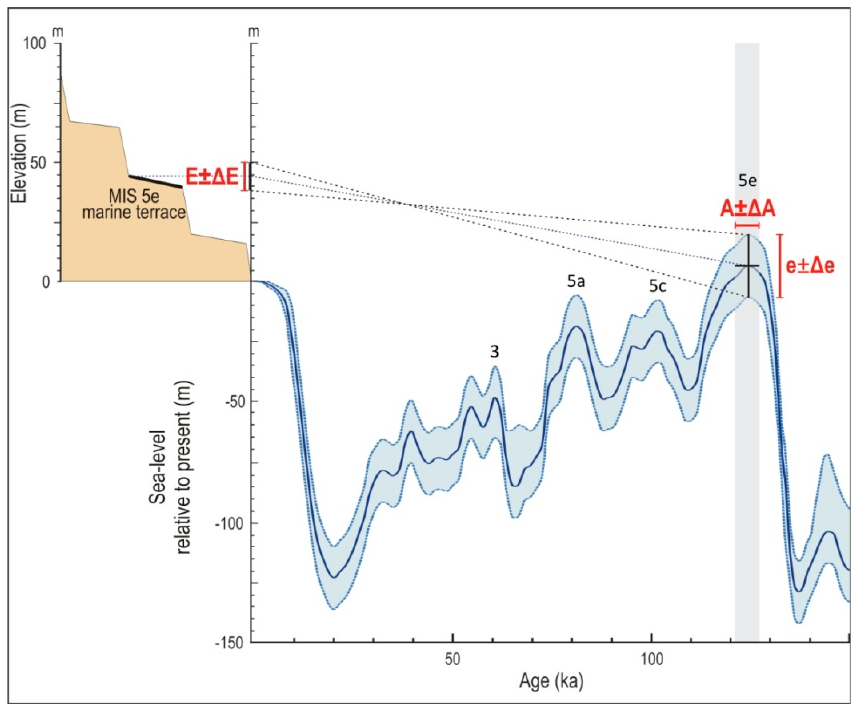
Figure 3. Schematic representation of the uncertainties taken into account for the long-term uplift rates estimations, as well as for the correlation of the marine terraces with past sea-level highstands. E is the present-day elevation of the inner edge of the terrace, A is the age of the terrace, e corresponds to the elevation of the sea level at the time of terrace formation, and the delta symbols ( Δ ) represent the estimated uncertainty in the different parameters. The marine terrace of MIS 5e is used as an example. The age of the other undated terraces has been inferred from their correlation with past MIS sea-level highstands. Assuming a temporally constant uplift rate [4–6,8,20,89] and taking into account the duration of each MIS [88] as well as the maximum and minimum position of eustatic sea-level for each MIS highstand [25], we estimated the “expected” (or “predicted”) elevation ranges of the inner edge for each MIS marine terrace. The predicted elevations were then compared with the observed elevations of the marine terraces, and for each terrace, an MIS was assigned. This is a model generally used since the dating of marine terraces is sometimes difficult, and very often, only one—if any— terrace can be reliably dated. 4. Results and Discussion 4.1. Mapping The application of mapping techniques led to the identification of a sequence of 10 uplifted marine terraces along the coastline between cape Koulendi and Agia Marina, west of cape Maleas, with inner edges’ elevation ranging between 8 ± 2 m and 172 ± 2 m (Figures 4 and 5) . On Elafonissos Island, the marine terraces flight, consisting of 10 emerged abrasion platforms, can be traced with shoreline angles (inner edges) ranging in elevation from 8 ± 2 m to 192 ± 2 m. A detailed map of the marine terraces (numbered T1–